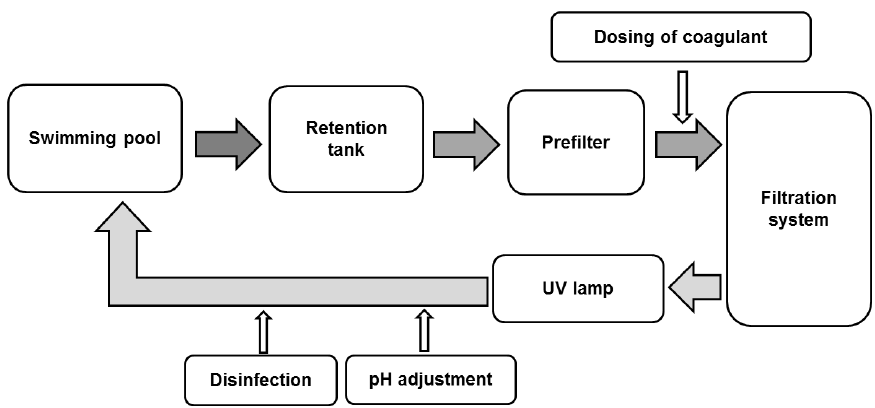
Figure 1. Diagram of typical water treatment installation in swimming pools.